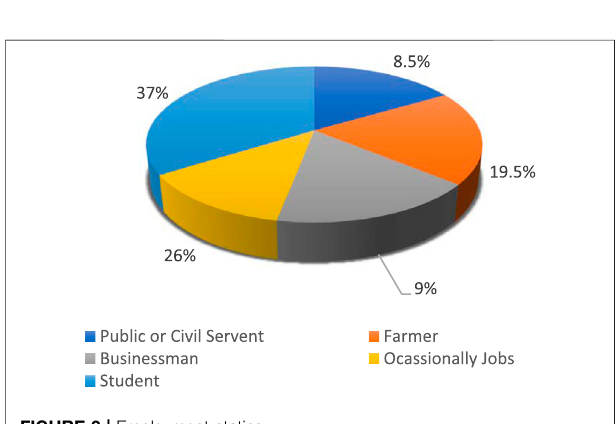
FIGURE 3 | Employment